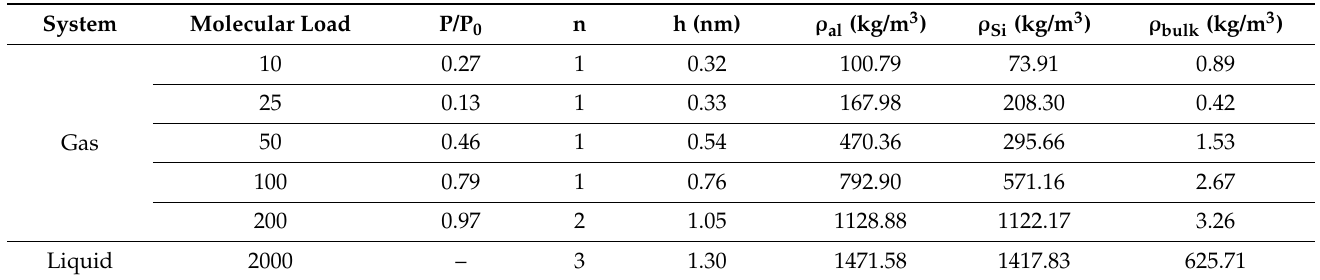
Table 2. Densities of the adsorbed layers and the bulk for gaseous and liquid n-pentane system, and the associated relative pressure.